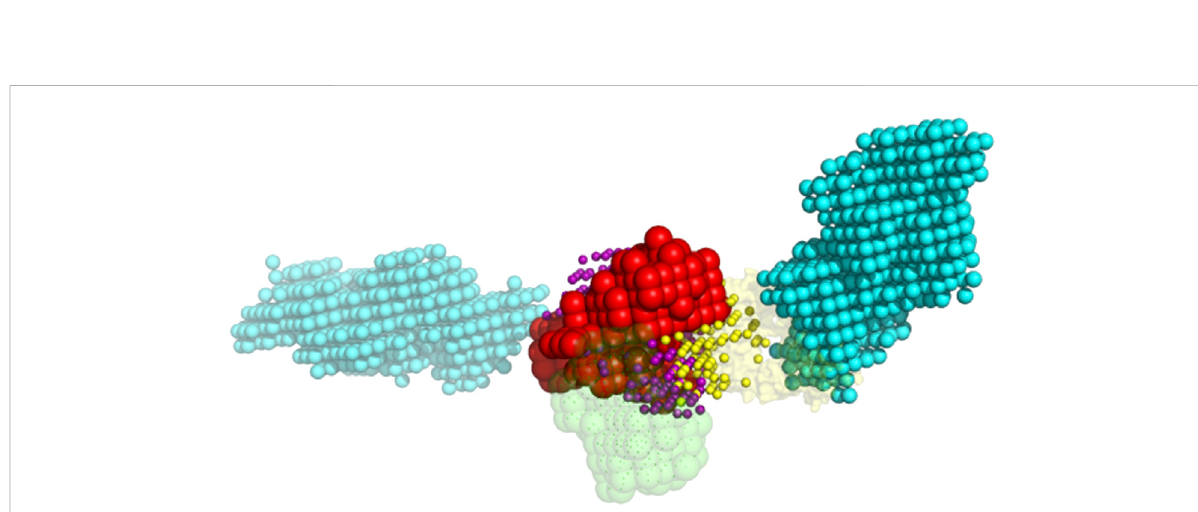
FIGURE 4 Example of the ligand poses excluded due to the clash with crowders. The red and green spheres are the grid projections of the receptor (1s78 chain A) and thenative pose ofthe ligand (1s78 chains CD),correspondingly. The cyan spheres are thegrid projection of thetwo BSAcrowders from Figure 3. The yellow and purple spheres are the geometric centers of the docked ligand from 1,000 lowest-energy poses that do and do not clash with the crowders,